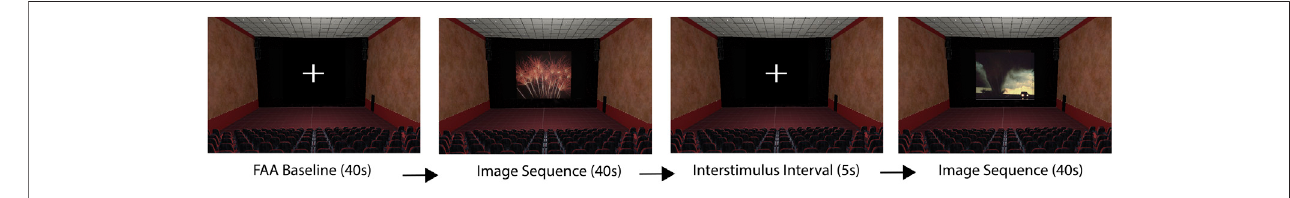
FIGURE 6 | A visualization of the VR application showing two randomized image